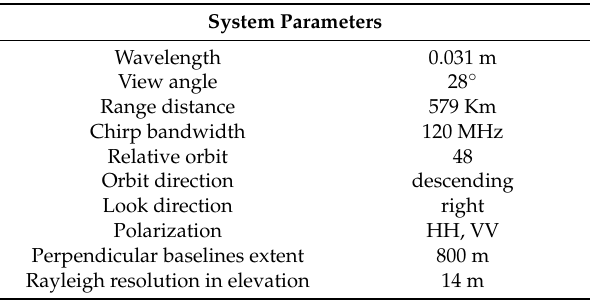
Table 1. TSX system